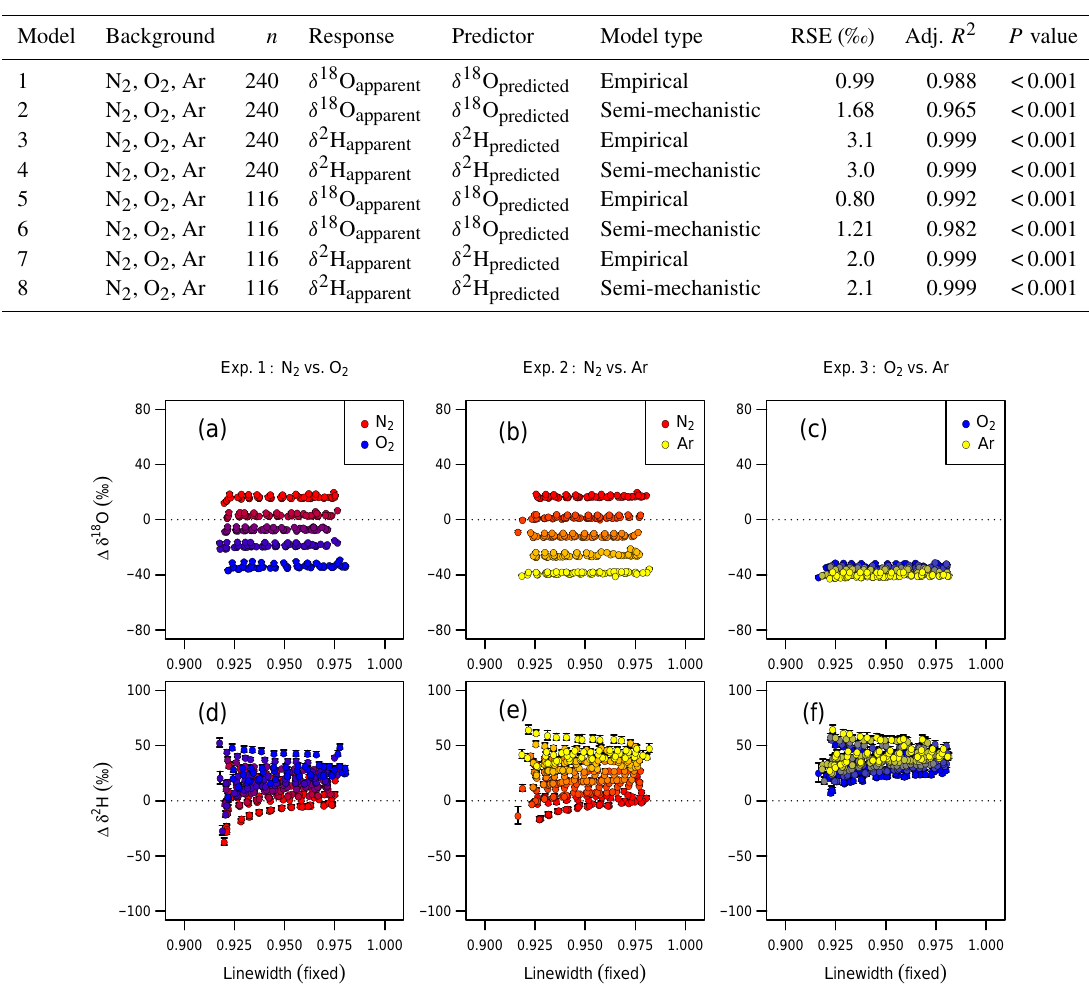
Figure 8. Relationship between the fixed linewidth parameter, (cid:49)δ 18 O, and (cid:49)δ 2 H values. For each panel, n = 330 measurements of four liquid standards across a range of injection volumes (i.e., 400–2400nL, in 11 steps of 200nL each). Points represent mean values ± SD for replicates of each standard at each injection